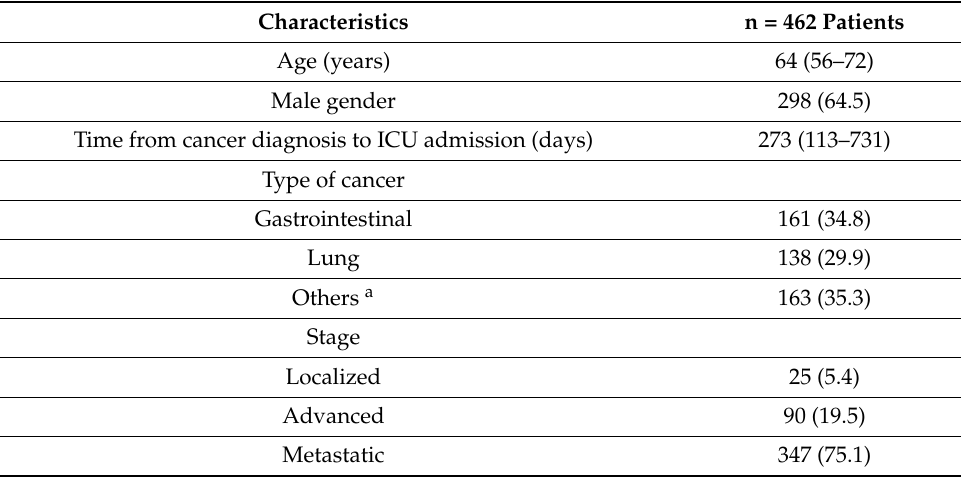
Table 1. Patients’ characteristics and